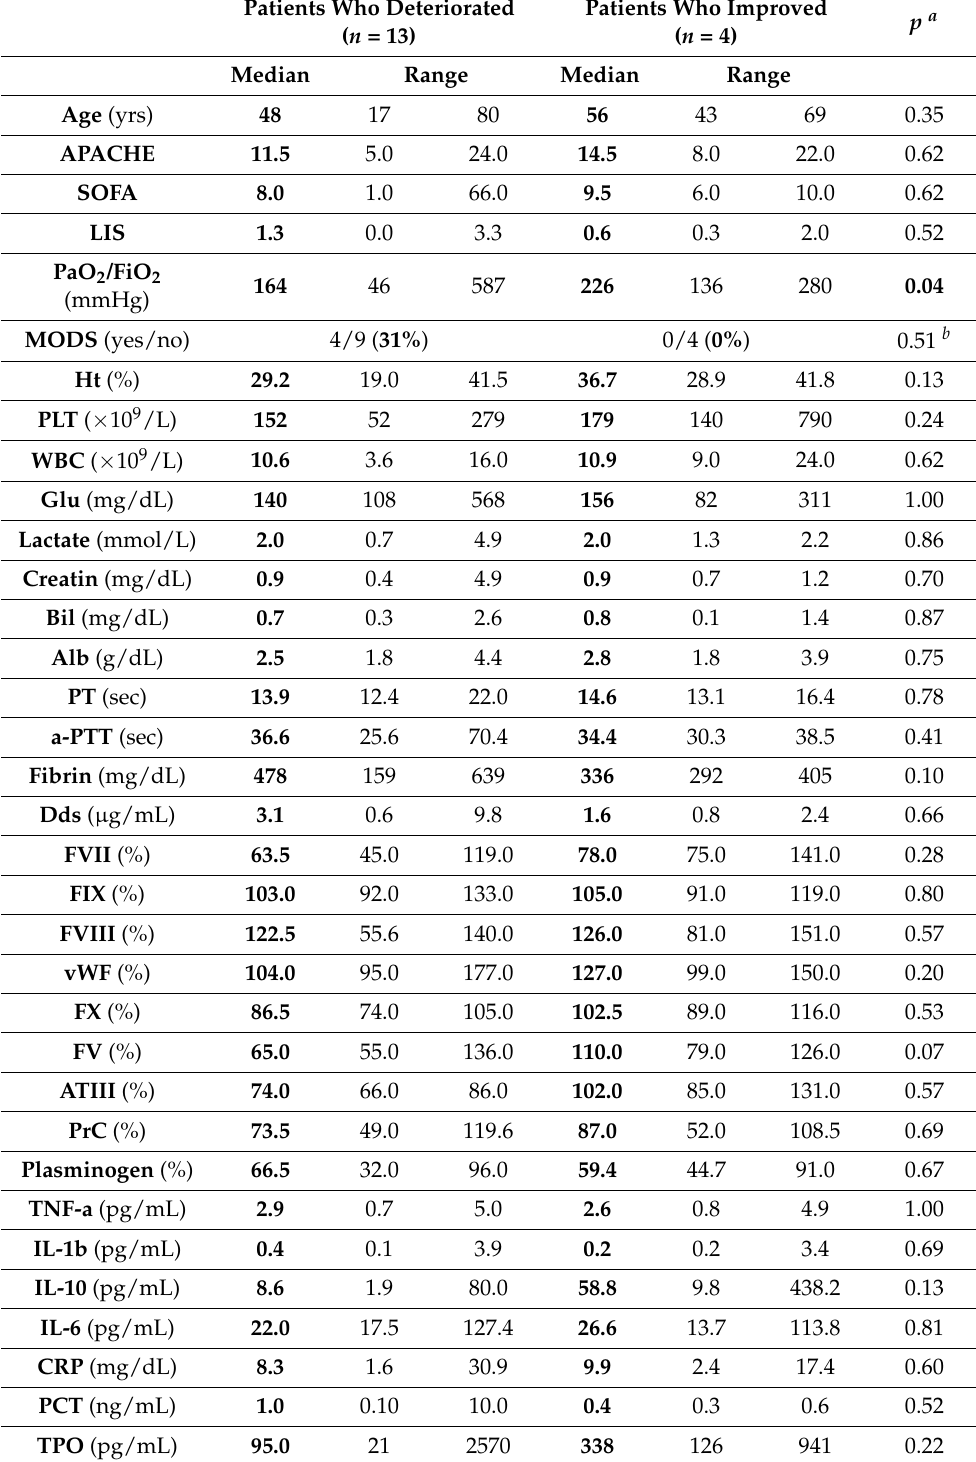
Table 4. Diagnosis of Systemic Inflammatory Response Syndromeon ICU